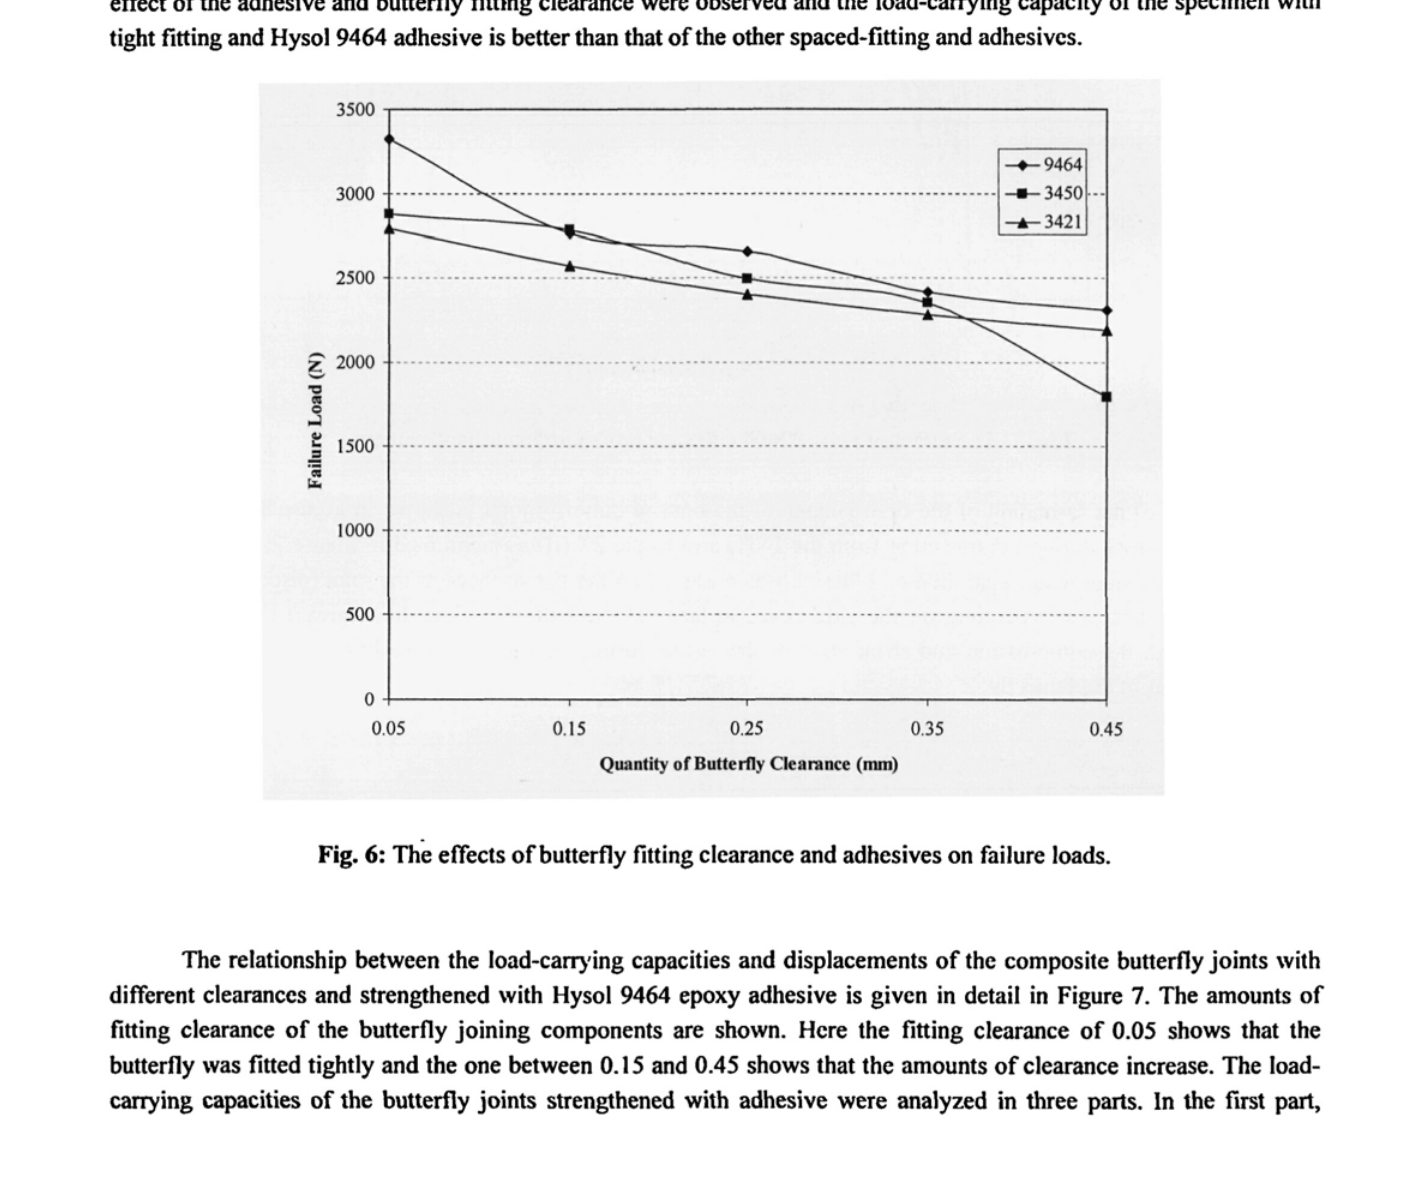
Fig. 6: The effects of butterfly fitting clearance and adhesives on failure